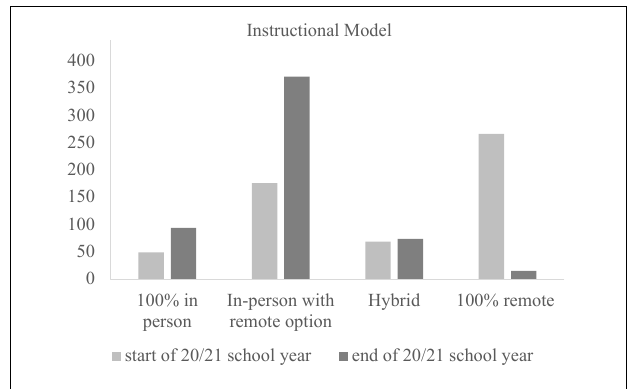
FIGURE 1 | Teacher-reported school instructional